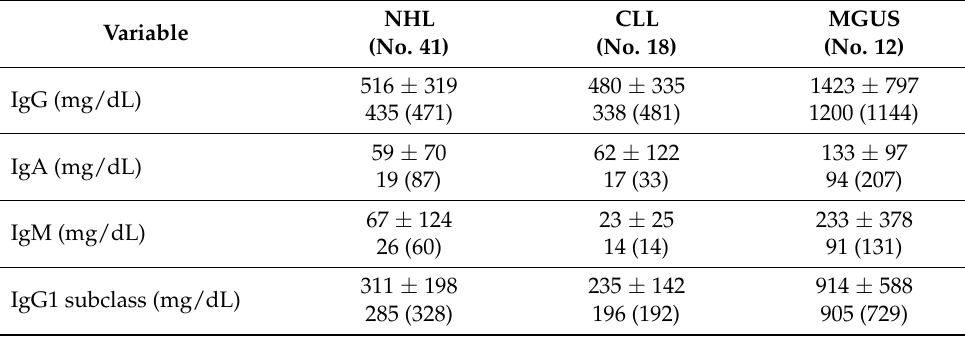
Table 1. Immunological characteristics of the main cohort groups.